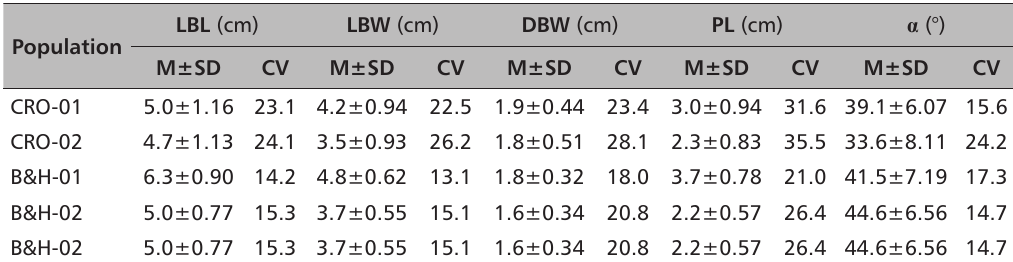
taBle 3. Descriptive statistics of the measured morphological traits at the group level